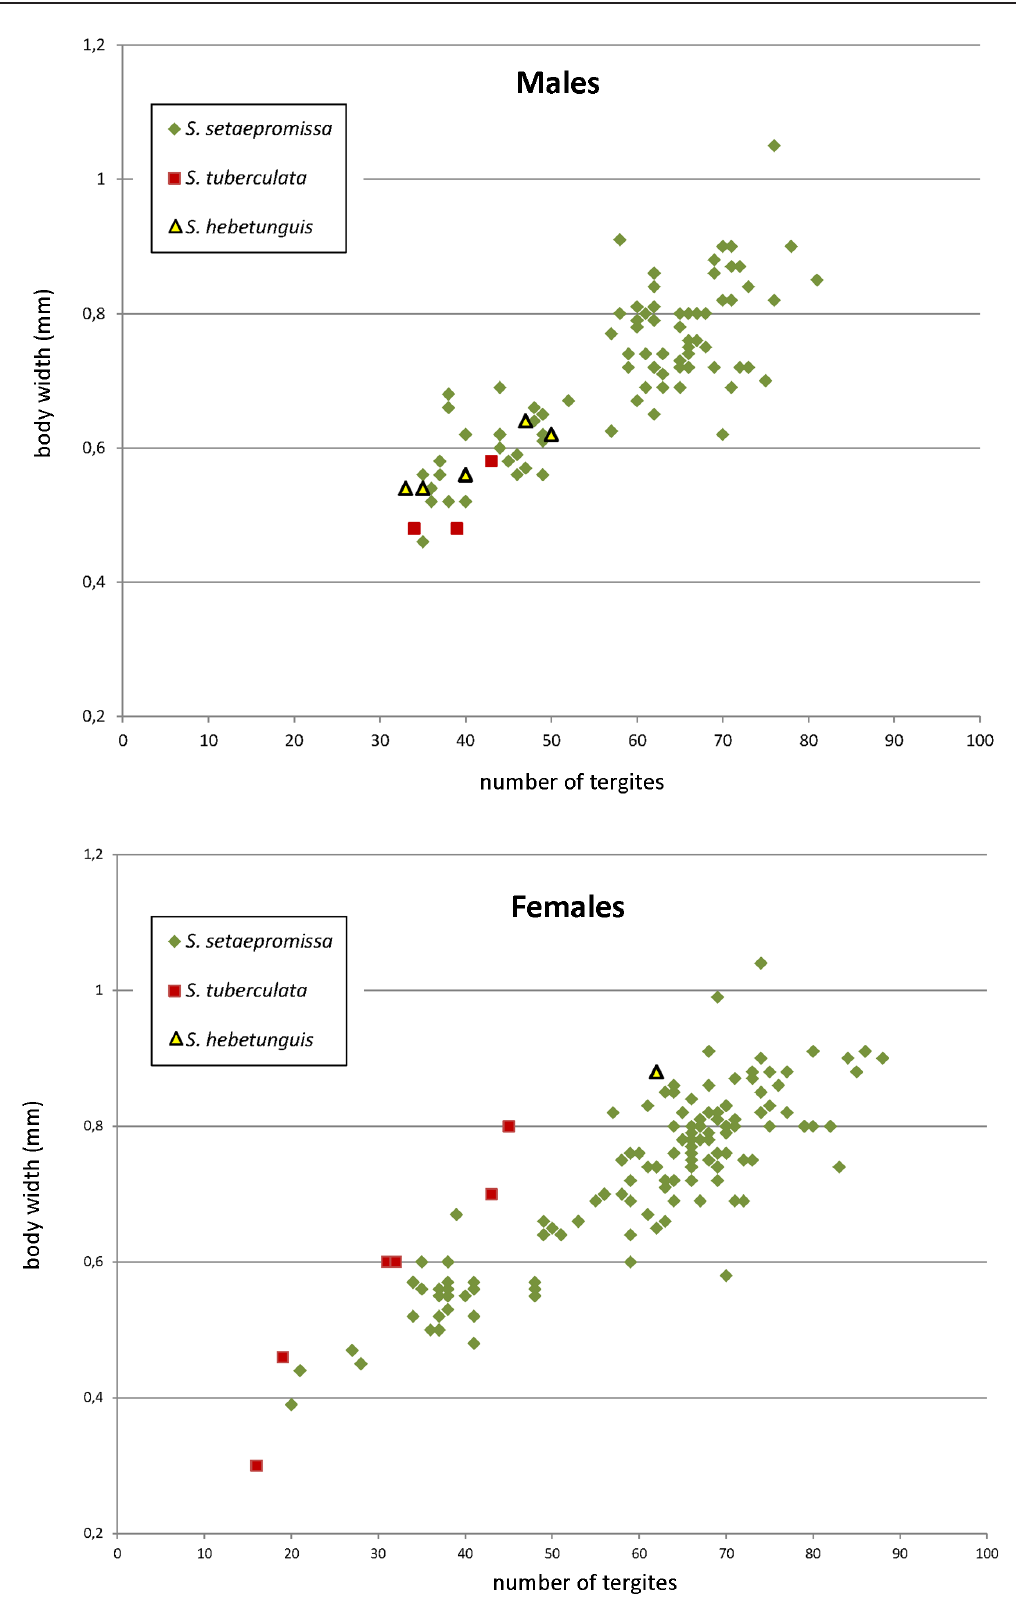
Fig. 1. Relationship between body width (mm) against the total number of tergites with legs for new species of Siphonophora Brandt, 1837 and S. hebetunguis (Attems,